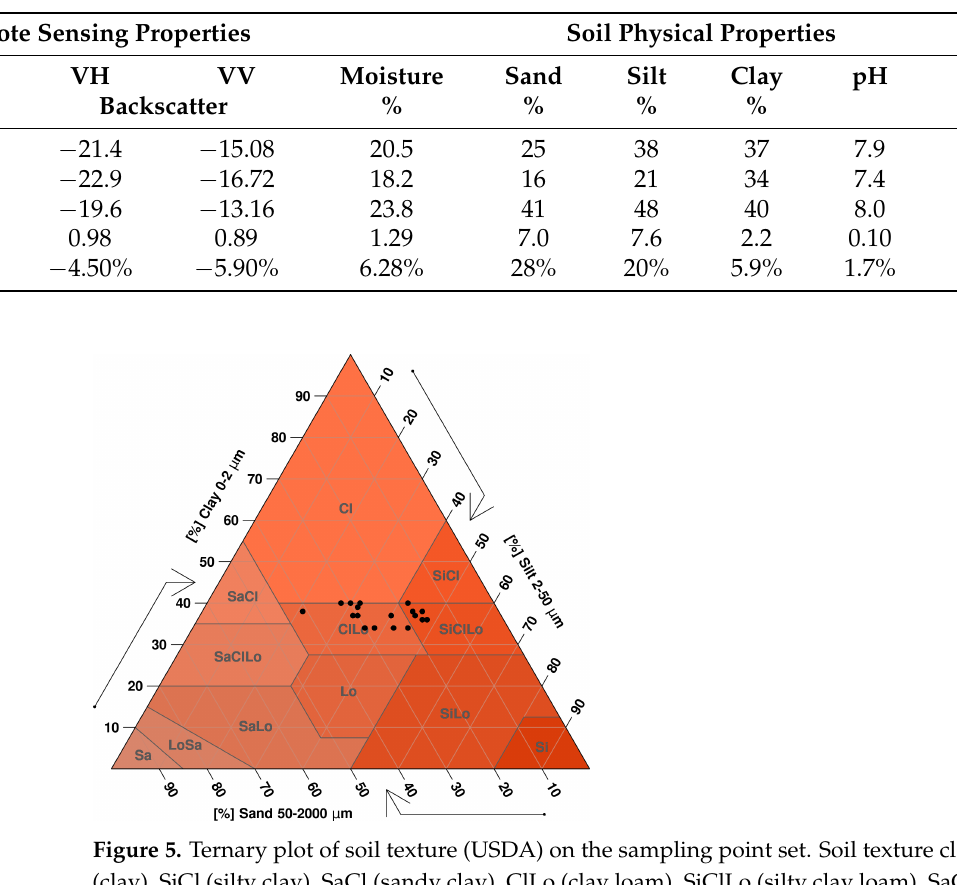
Table 2. Descriptive statistics for remote sensing and soil physical properties on sampling point set. Abbreviations: AVG: average, MIN: minimum value, MAX: maximum value, STD: standard deviation, CV: coefficient of variation (i.e., STD / AVG · 100); NDVI: Normalized Difference Vegetation Index. See Table 1 for soil physical abbreviations and units of measures and Figure 4 for remote sensing abbreviations.